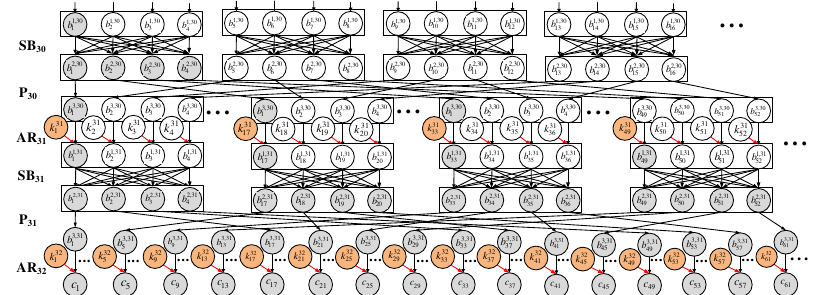
Figure 4: Example: Finding Key Parts for the Distinguisher Evaluations in PRESENT